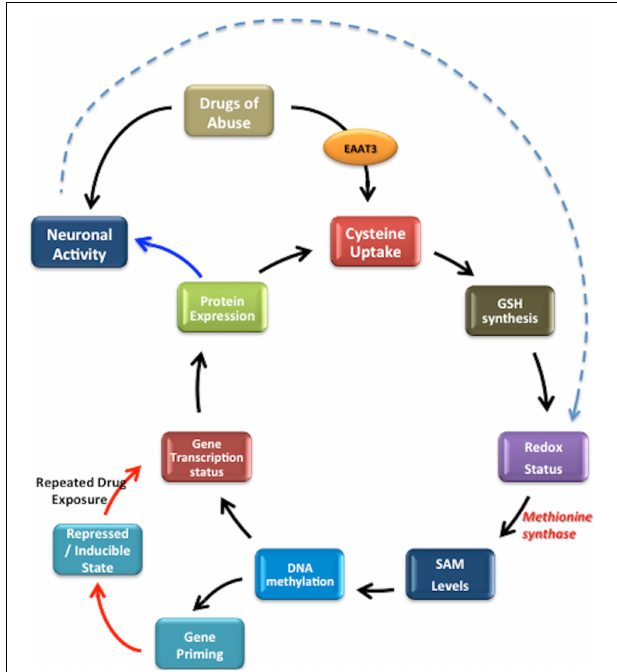
FIGURE 5 | Summary: Redox-based epigenetic signaling. Drugs of abuse alter cysteine uptake, affecting GSH synthesis, which shifts redox status and the reducing potential. This shift affects methionine synthase (MS) activity further affecting the probability of DNA methylation i.e., epigenetic changes, subsequently inducing changes in gene transcription or gene inducibility. If a repeated stimuli occurs, it results in altered gene transcription. This eventually affects the protein expression and consequently neuronal functionality and phenotype. Dotted line indicates that, neuronal activity can also redox status by altering the levels of ROS